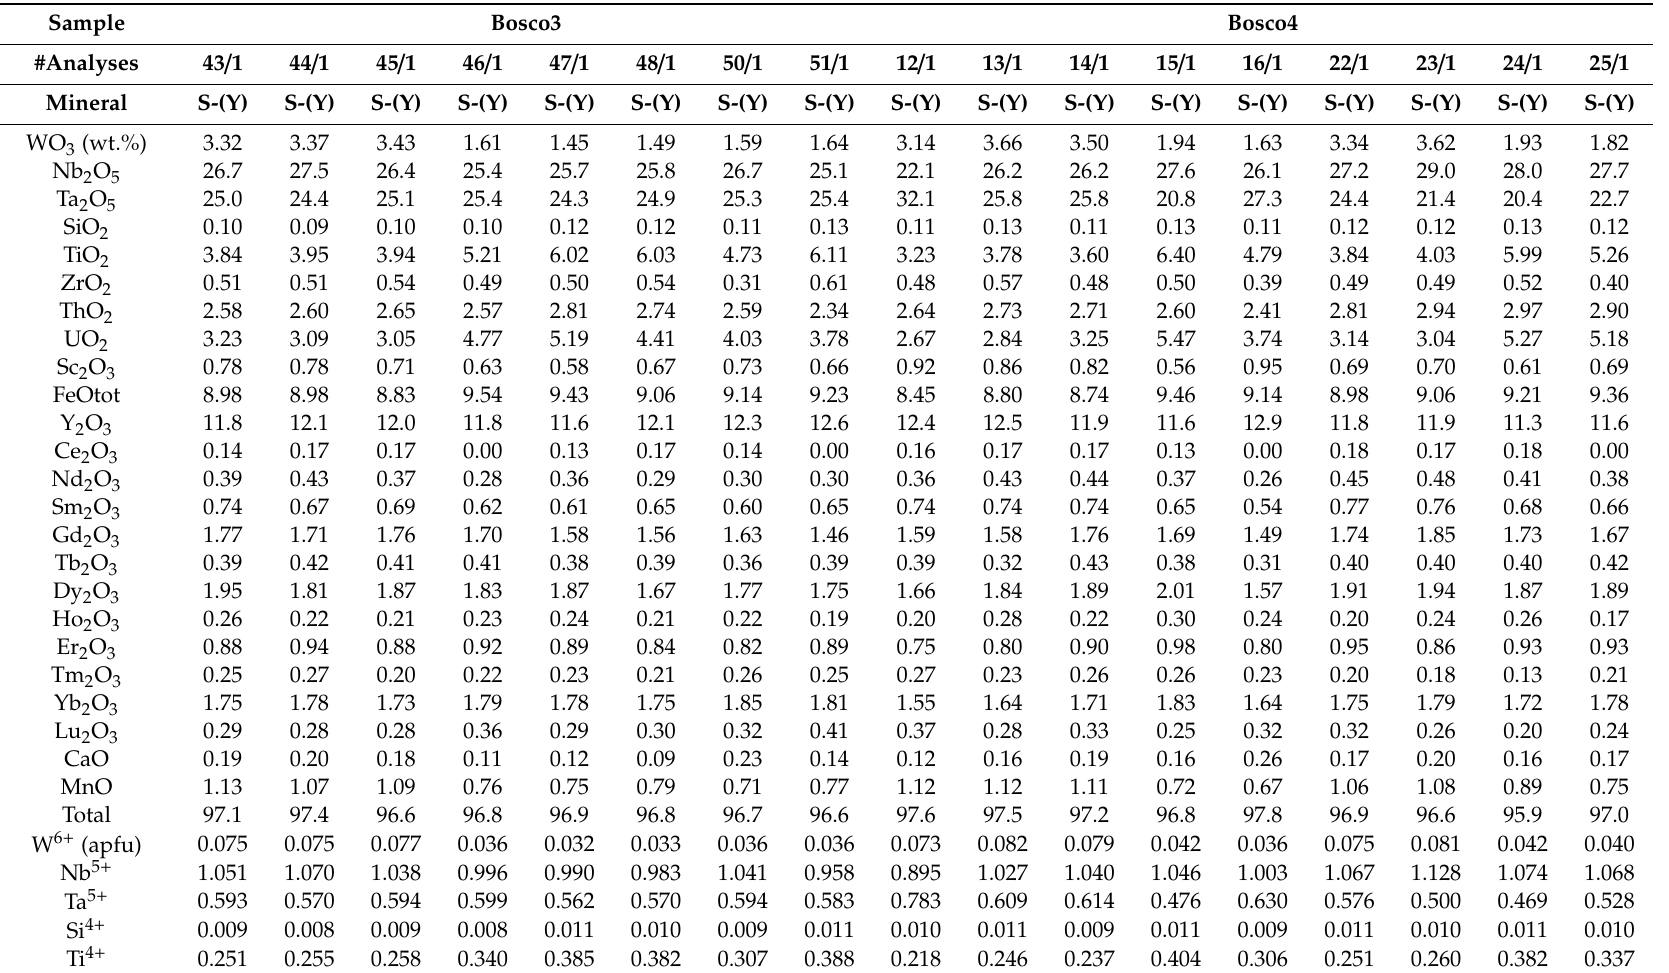
Table 2. Representative chemical compositions (in wt.% ) and mineral formulae (in apfu) of samarskite-(Y) from Bosco pegmatites at Arvogno.